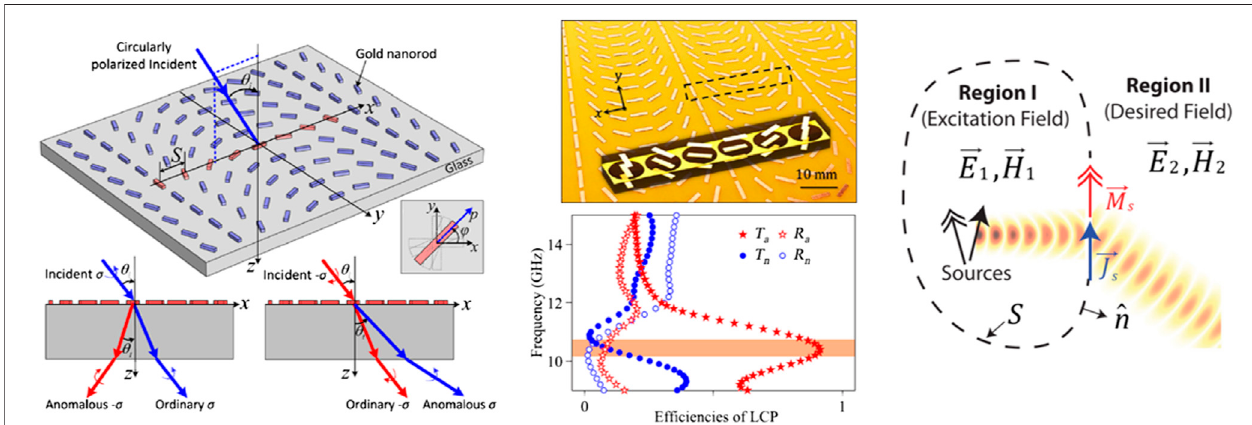
FIGURE2|(A) SchematicdiagramofnormalandanomalousrefractionbyPancharatnam – BerrymetasurfacewhenilluminatedbyLCPandRCPlight,respectively, [57]. (B) Picture of fabricated Pancharatnam – Berry metasurface exhibiting both electric and magnetic responses and its ultra-high transmissive conversion ef fi ciency [102]. (C) The surface equivalence principle is employed to fi nd the fi ctitious electric and magnetic surface currents that satisfy the boundary conditions [116]. Figure reproduced with permission from: (A) , © 2012, American Chemical Society (ACS); (B) , © 2017, American Physical Society (APS); (C) , © 2013, American Physical Society